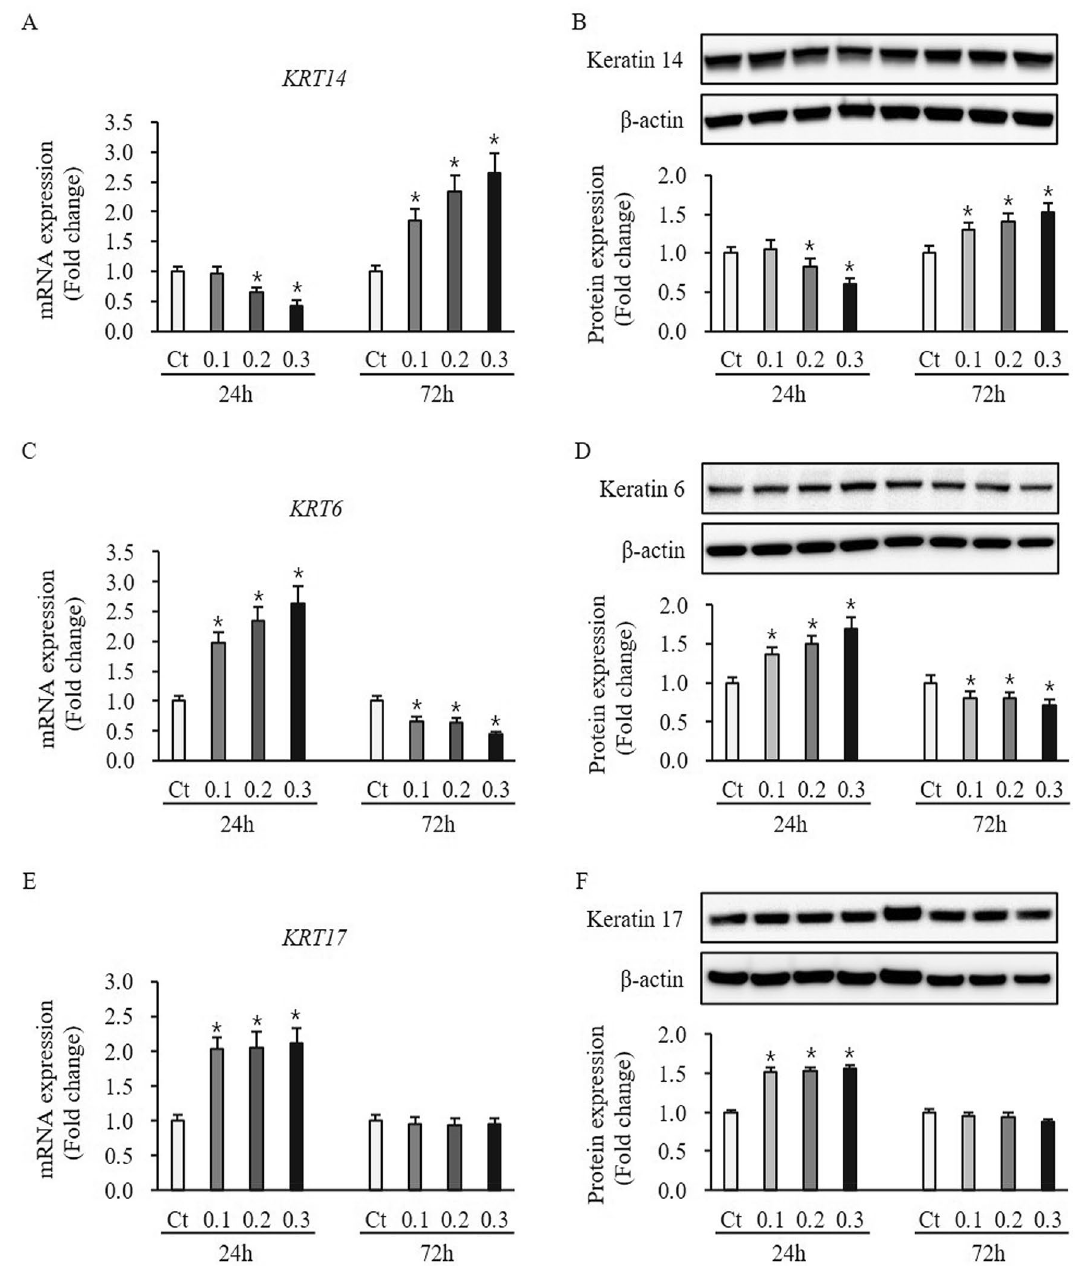
Figure 5. Expression of proliferation and activation marker in HTSKs after ESWT. Significantly decreased and increased mRNA (A) and protein levels (B) of keratin 14 ( KRT14 ), a proliferation marker in HTSKs at 24 h or 72 h after ESWT under 0.2, and 0.3 mJ/mm 2 of energy flux density, comparted with those in untreated control. Significantly increased and decreased mRNA (C) and protein levels (D) of keratin 6 ( KRT6 ), an activation marker in HTSKs at 24 h or 72 h after ESWT under 0.1, 0.2, and 0.3 mJ/mm 2 of energy flux density, comparted with those in untreated control. Significantly increased and unchanged mRNA (E) and protein levels (F) of keratin 17 ( KRT17 ), anther activation marker in HTSKs at 24 h or 72 h after ESWT, comparted with those in untreated control. In the fold change, untreated control cells marked as value 1; Ct, untreated control cells; HTSK, hypertrophic scar keratinocyte; * P < 0.05 for ESWT-treated cells vs. the corresponding matched untreated control cells. Data represent means ± SD; n =